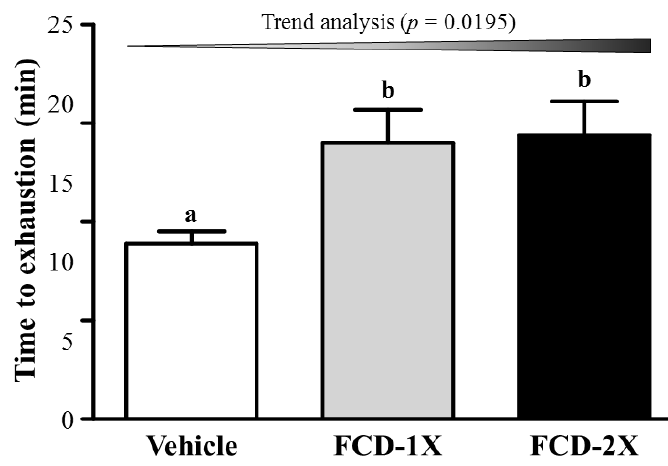
Figure 2. Effect of FCD (Fucoidan) supplementation on swimming exercise